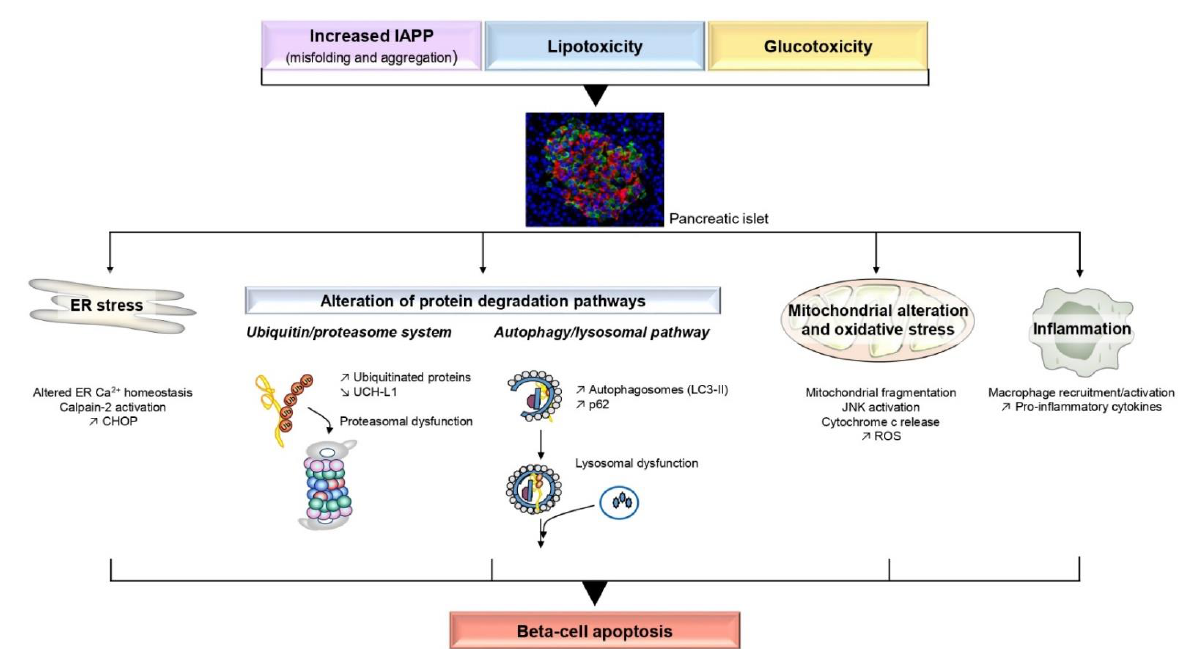
Figure 1. Main mechanisms involved in pancreatic beta-cell apoptosis under T2D-prone situations. Increased islet amyloid polypeptide (IAPP) levels with misfolding and aggregation, lipotoxicity and glucotoxicity are the most investigated causative factors of beta-cell demise. These situations individually elicit stress pathways such as endoplasmic reticulum (ER) stress, mitochondrial/oxidative stress, inflammation, and disrupt the main pathways of protein clearance (ubiquitin-proteasome system and autophagy/lysosomal pathway). The synergistic deleterious effects of these situations as well as the crosstalk between the stress pathways ultimately contribute to beta-cell apoptosis. The immunofluorescence image is a human islet showing beta-cells in red and alpha-cells in green.